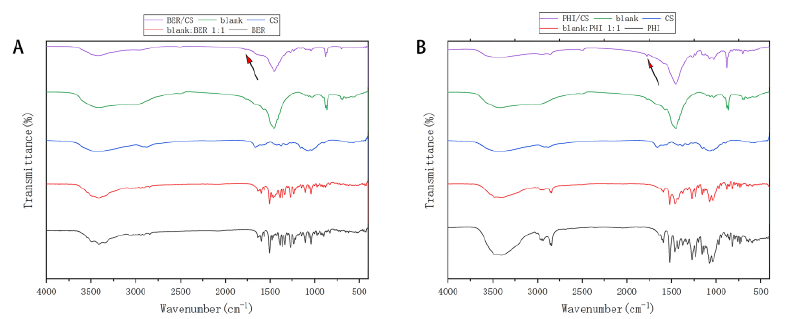
Figure 4. FTIR patterns of ( A ) BER/CS, blank, CS, blank:BER 1:1, BER; ( B ) PHI/CS, blank, CS, blank:PHI 1:1 and PHI.